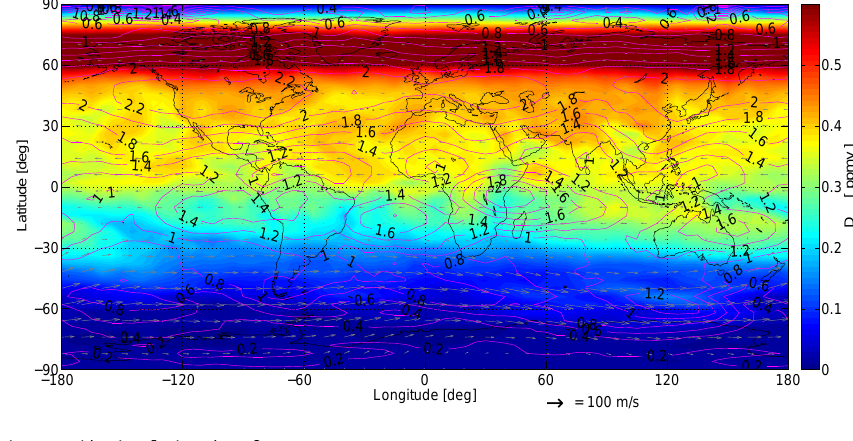
Figure 7b. Same as Fig. 7a with simulation data from June.